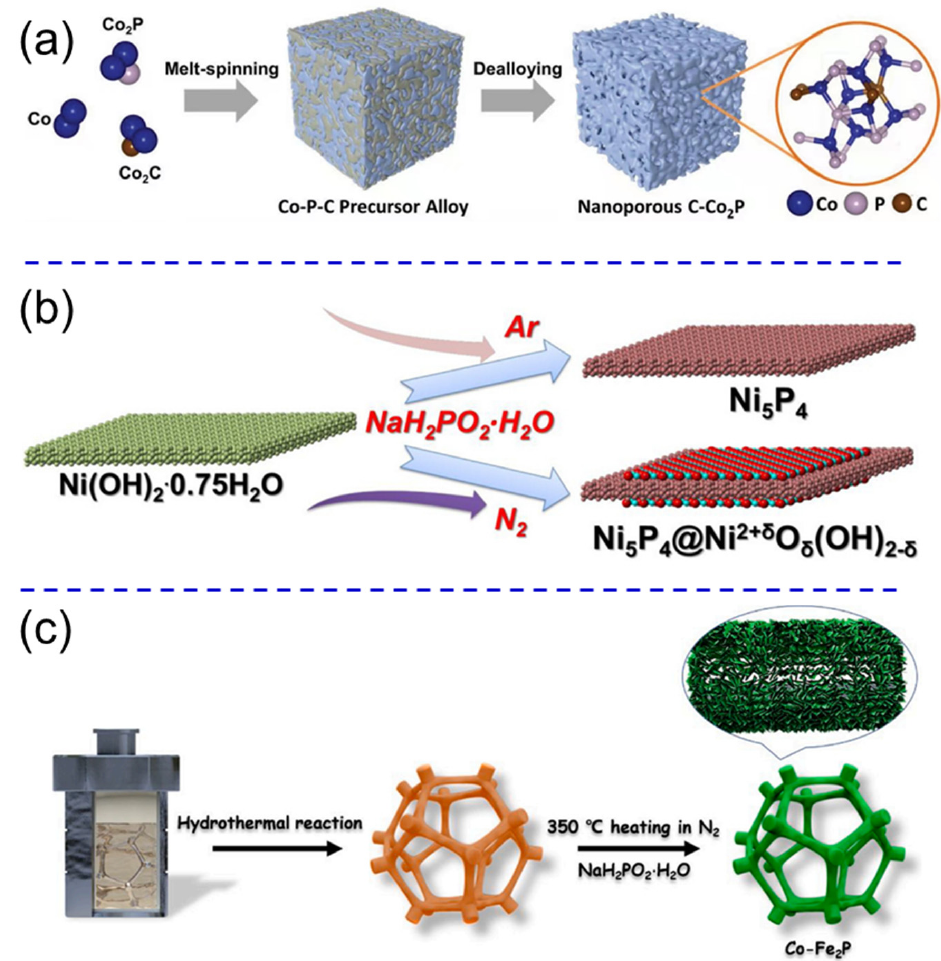
Figure 3. ( a ) The preparation procedure of C-Co 2 P electrocatalysts [22]; ( b ) schematic illustration of NPNNS hybrid nanosheets [23]; ( c ) the synthesis process of the Co-Fe 2 P electrocatalyst